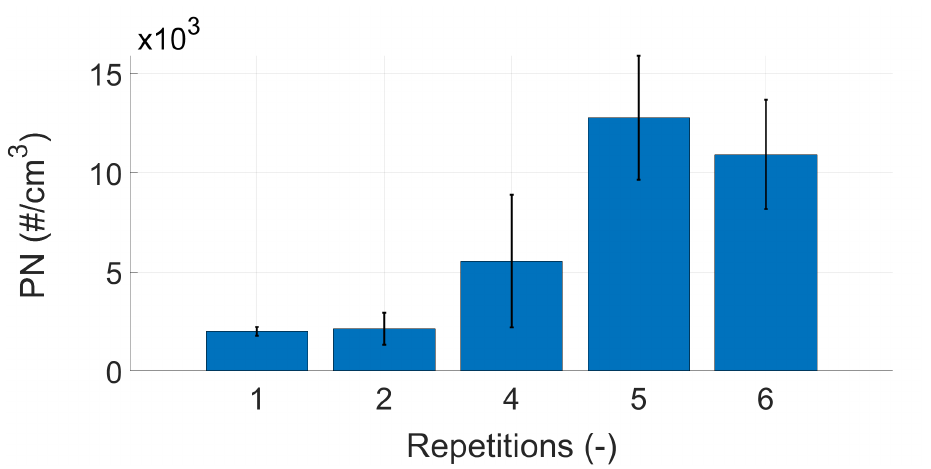
Figure A2. The mean values of PN measurements of gasoline (cut-off: 7 nm) without the outlier.